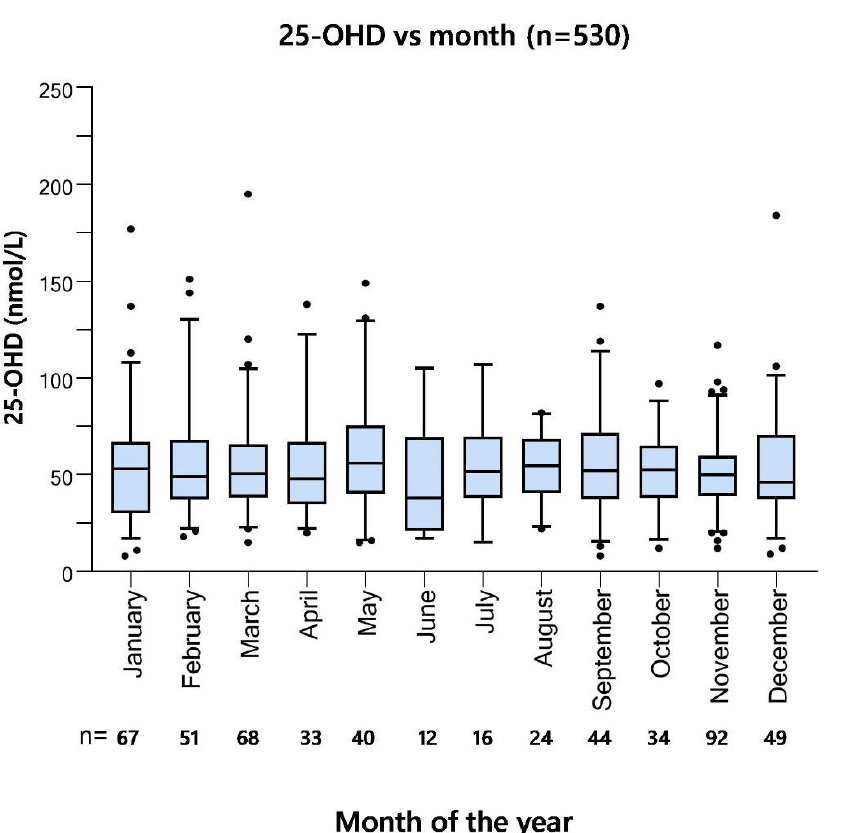
Figure 2. Cross-sectional 25-OHD in relation to screening month. Median 25-OHD values in nmol/L in the screening cohort ( n = 530) of the ‘Palliative-D’ study. Boxes show interquartile range whiskers 5/95 percentiles and dots outliers. There were no statistically significant differences between groups (Mann-Whitney U).